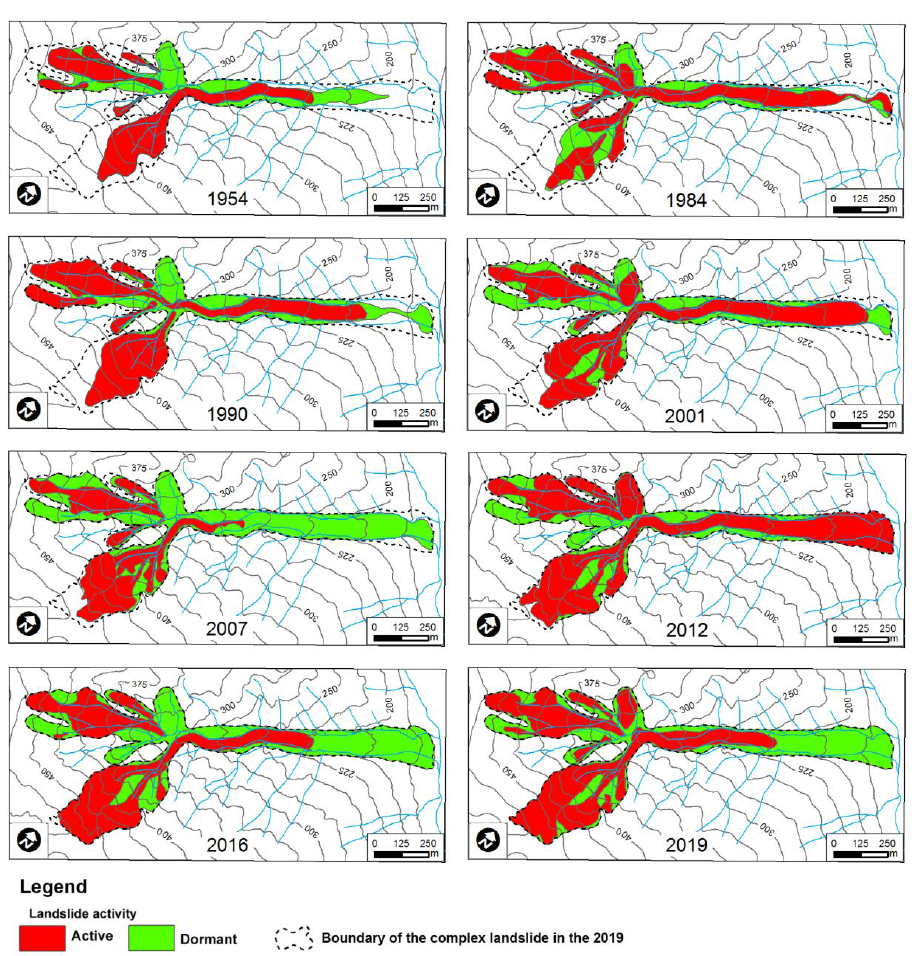
Figure 7. Space-time evolution for the Vomice earthflow. In all maps, landslide bodies that were active or dormant at the date of the aerial photographs, orthophotos, or satellite images were detected.